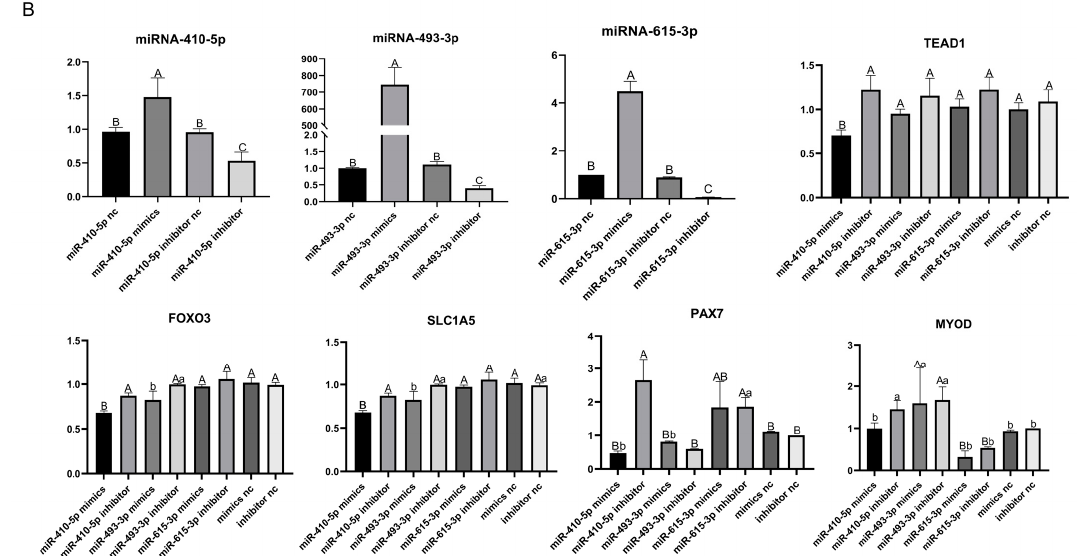
Figure 7. Validation of the targeting relationship between DE-miRNAs and the TEAD1 gene: ( A ) phenotype pictures of sheep primary embryonic myoblasts transfected with mimics and inhibitor of miRNA410-5p, miRNA493-3p, miRNA615-3p, mimics nc, and inhibitor nc. Scale bar, 200 µm; ( B ) qRT-PCR results of miRNA410-5p, miRNA493-3p, miRNA615-3p, TEAD1 , Pax7, MyoD , FoxO3, and SLC1A5 . a and b represent significant results, and A, B and C represent extremely significant results.